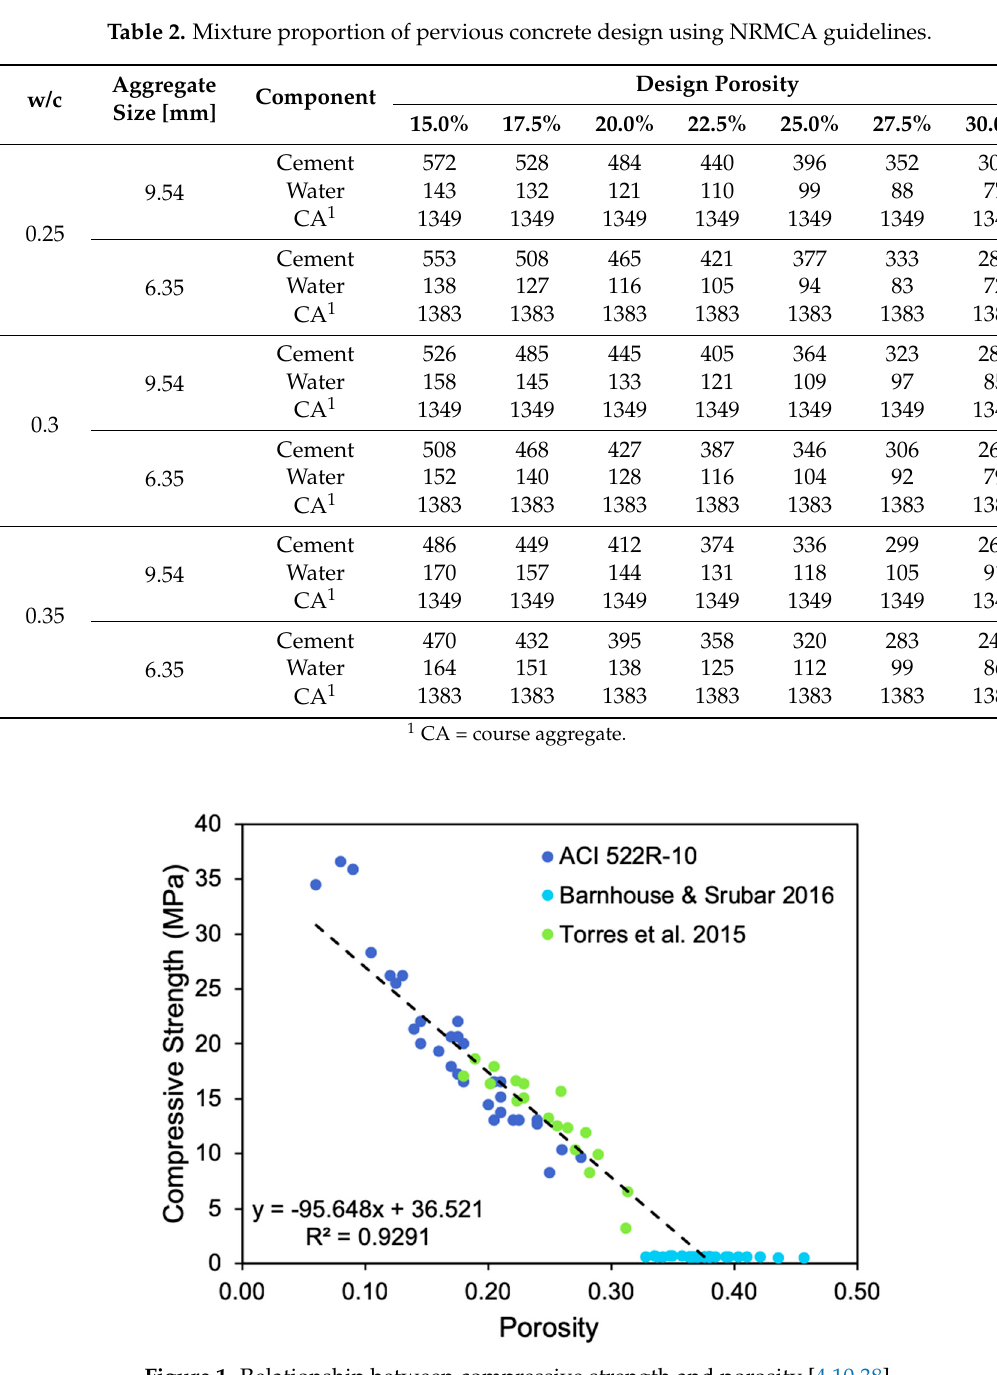
Figure 1. Relationship between compressive strength and porosity [4,10,38].